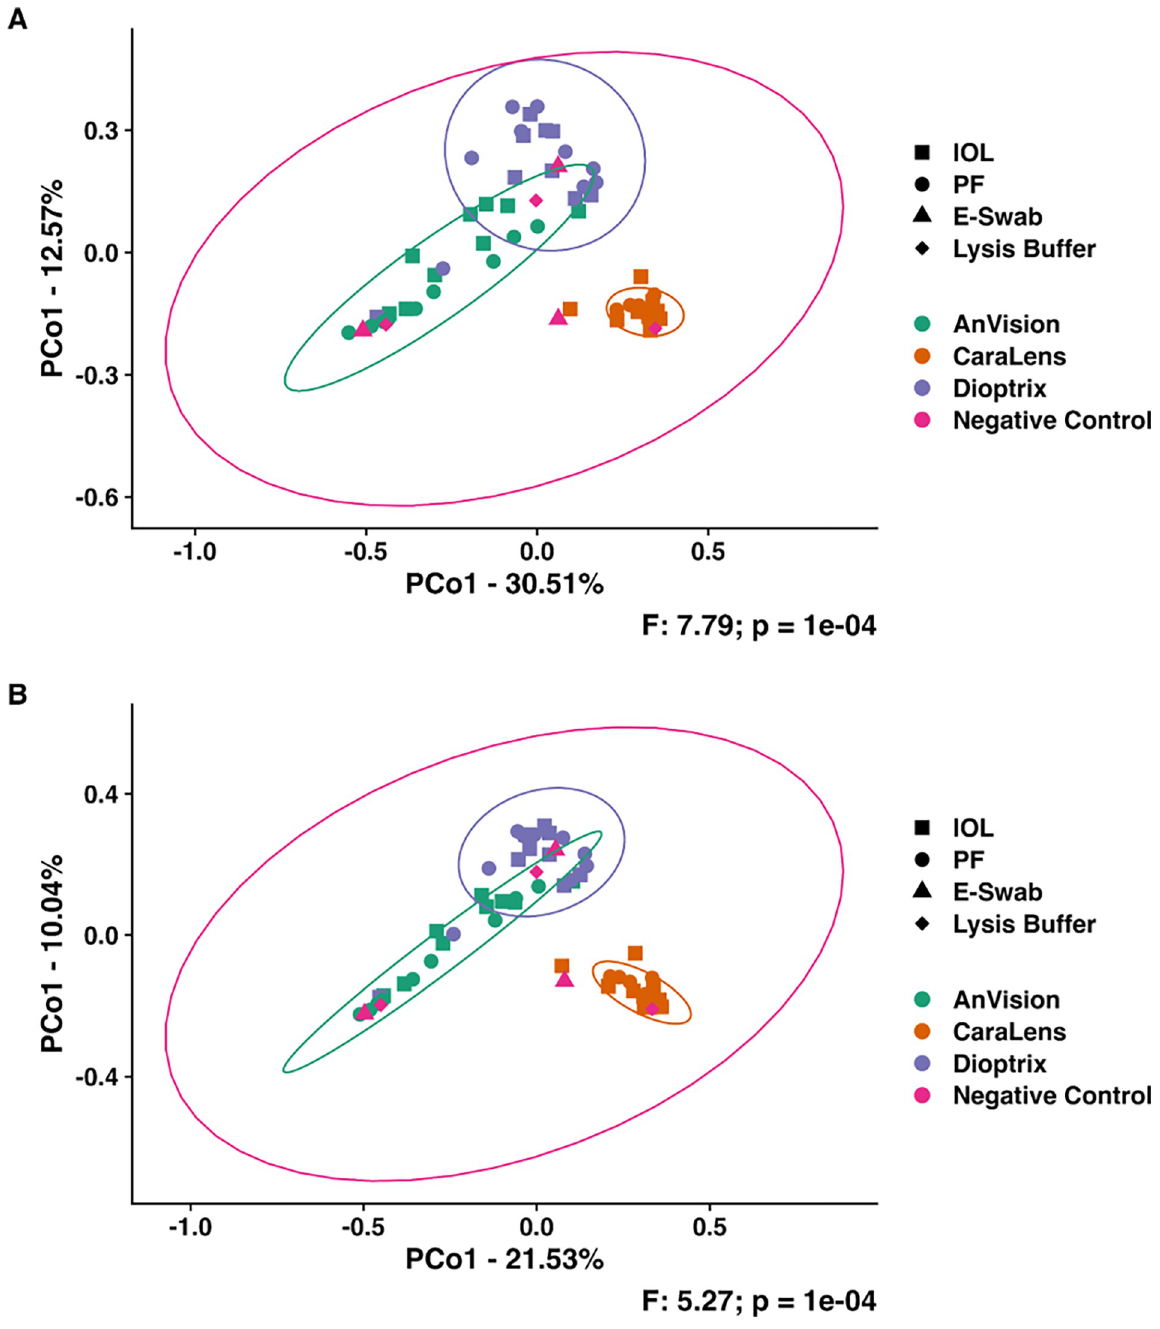
Fig 2. Principal coordinate analyses of each IOL manufacturer. Brand-specific clustering of microbial communities for intraocular lens ( ■ ), packaging fluid ( ● ), E-swabs ( ▲ ), and lysis buffer ( ◆ ) were found according to manufacturer. PCoAs using (A) Bray Curtis.and (B) Jaccard distances with 95% confidence